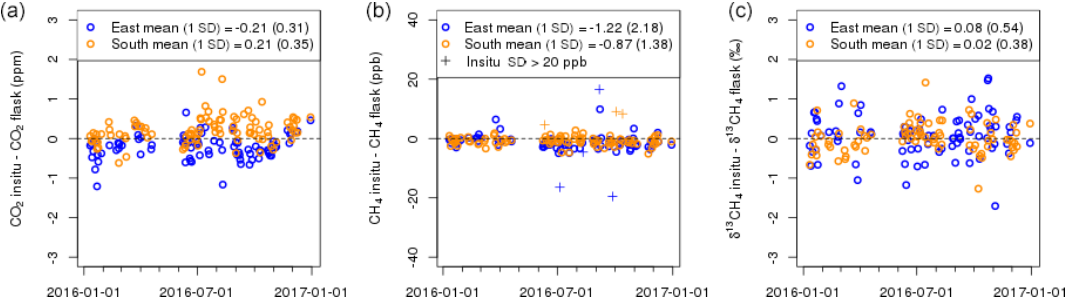
Figure 11. Afternoon in situ to flask differences for January–December 2016 for the east (blue) and the south towers (orange) for (a) CO 2 , (b) CH 4 , and (c) δ 13 CH 4 . For CH 4 , data points with high temporal variability (standard deviation of raw ∼ 2s data within the 10min segments >20ppb) are indicated by “ + ” symbols and have been excluded. The standard deviation of the in-situ-to-flask differences are shown in parentheses on each plot. The standard errors, indicating an estimate of how far the sample mean is likely to be from the true mean, is 0.24ppb CH 4 , 0.03ppm CO 2 , and 0.06‰ at the east tower and 0.14ppb CH 4 , 0.04ppm CO 2 , and 0.04‰ at the south